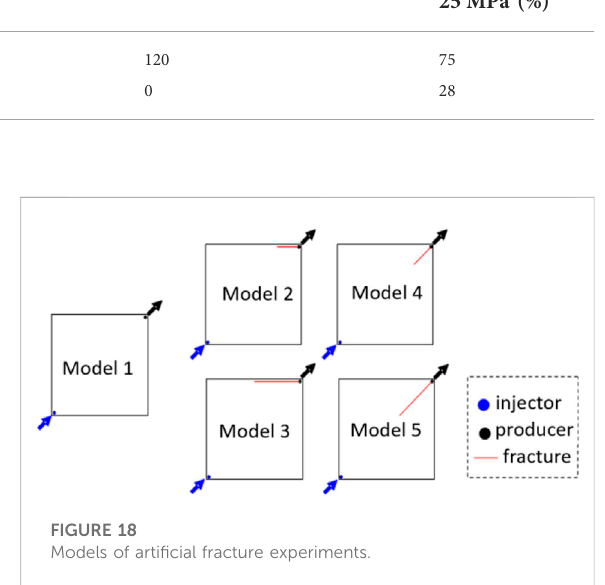
FIGURE 18 Models of arti fi cial fracture